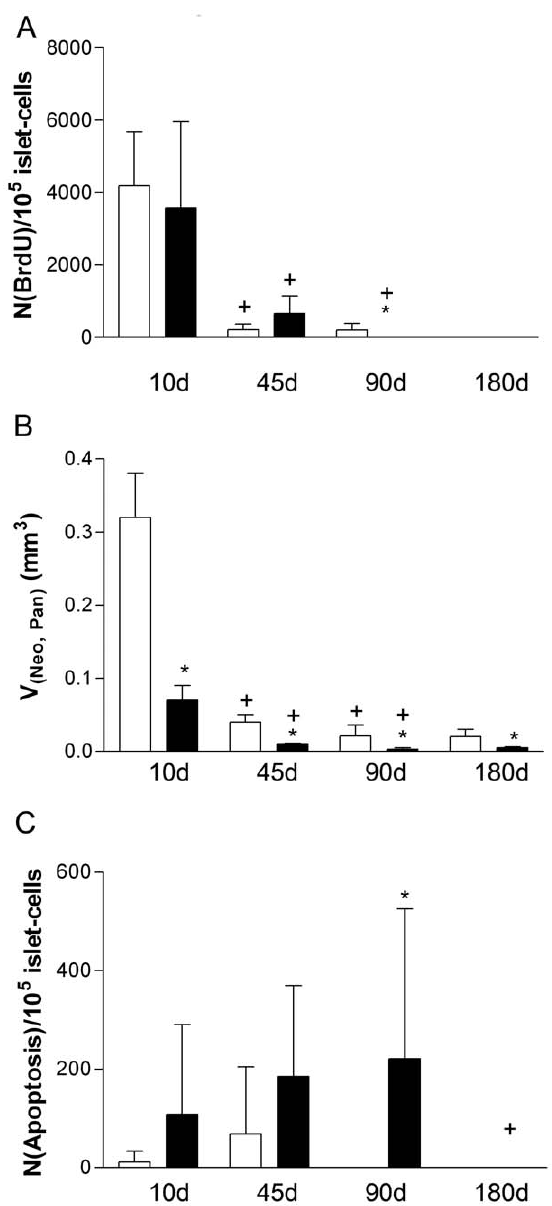
Figure 3. Islet-cell replication, isolated beta-cells, and islet-cell apoptosis. (A) number of BrdU positive islet cells per 10 5 cells (N (BrdU) ), (B) total volume of isolated beta-cells (V (Neo,Pan) , (C) number of apoptotic islet cells per 10 5 cells (N (Apoptosis) ). Open bars: female control mice; filled bars: female GIPR dn transgenic mice; Data represent means and SEM. * p , 0.05 vs. age-matched control; + p , 0.05 vs. previous time point.